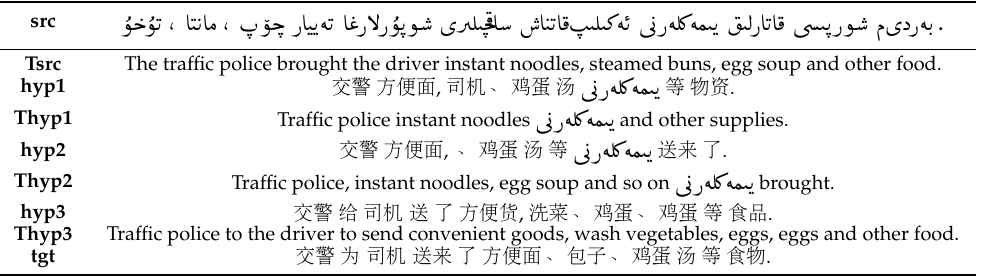
Table 1. Examples of multiple hypotheses. Tsrc, THyp1, THyp2, THyp3 are English translation of the src, hyp1, hyp2, hyp3,